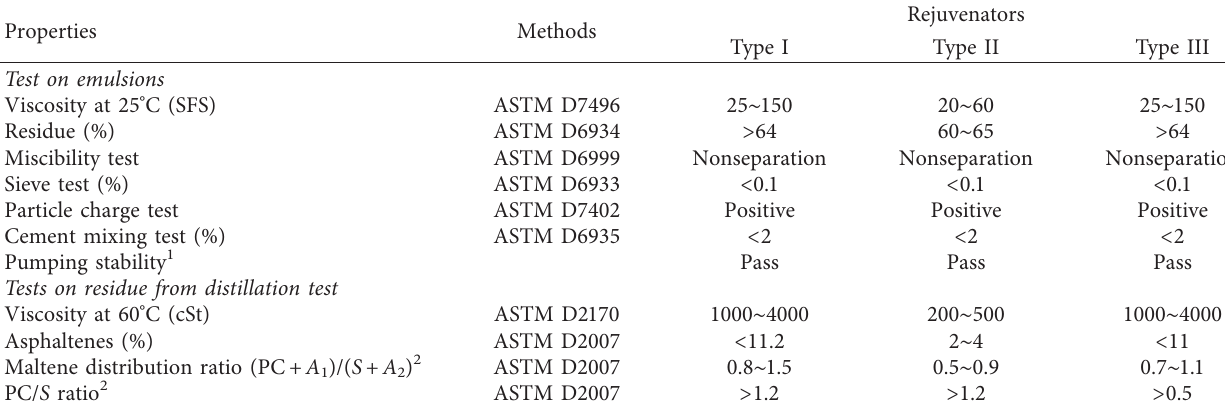
Table 2: The principal properties of rejuvenators Types I, II, and III.